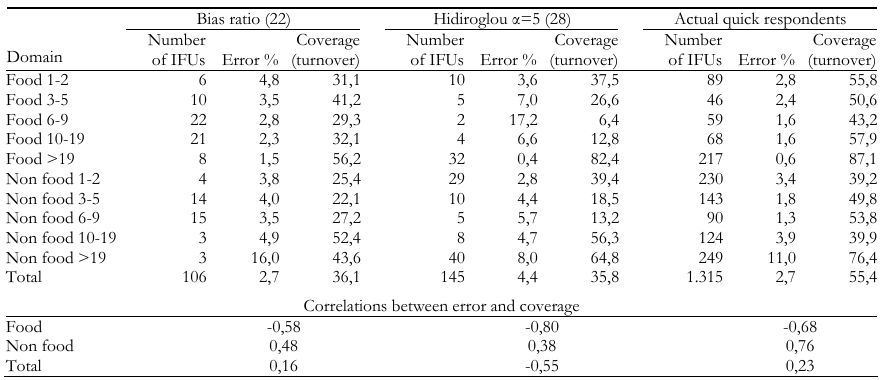
Main results using function Ф 2 and option a), formula (11), for 10 strata, using methods (22), (28) and the actual quick respondents – Estimation of level